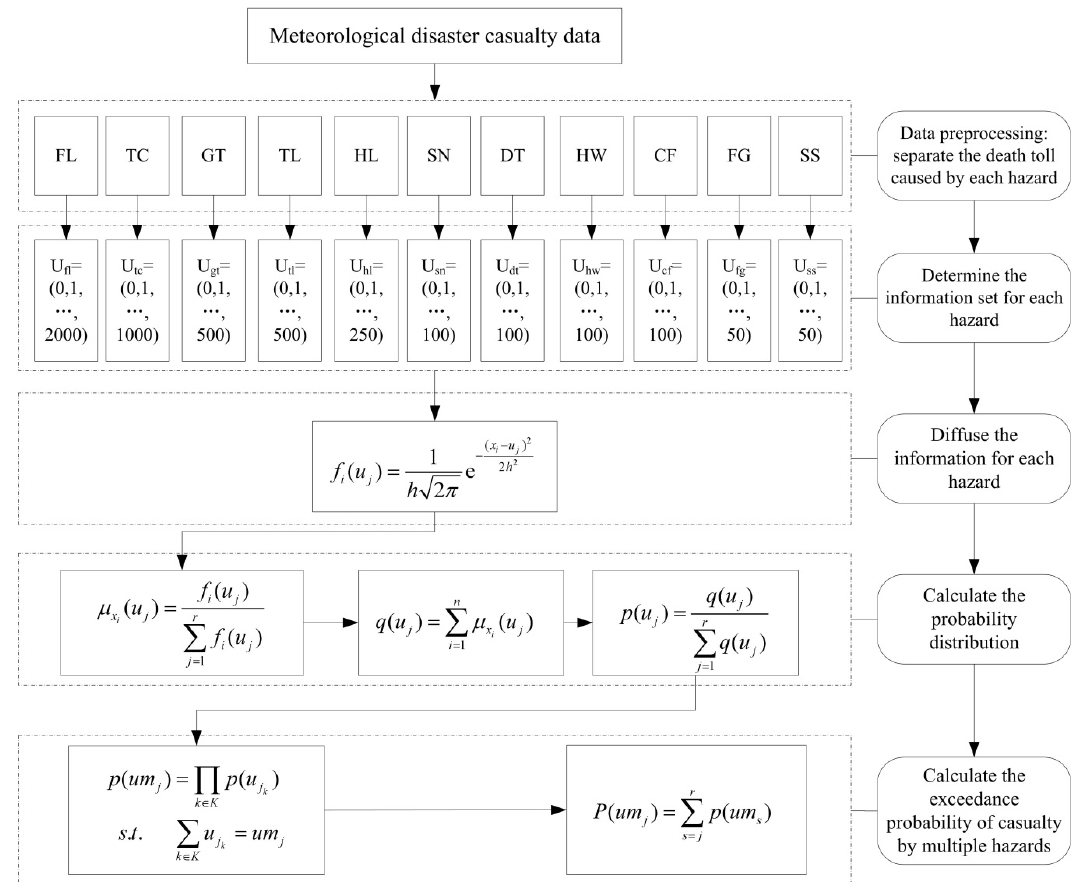
Figure 1. Steps for calculating the exceedance probability of the risk of casualty caused by multiple hazards using an information diffusion method. FL = heavy rain and flood (including waterlogging and storm-induced geological hazards); TC = typhoon (including typhoon-induced storm surges); GT = gales and tornados; TL = thunder and lightning; HL = hail; SN = snow; DT = drought; HW = heat wave; CF = cold spell and freezing; FG = fog; and SS = sand/dust storm. The parameters used in the equations are defined in the text.